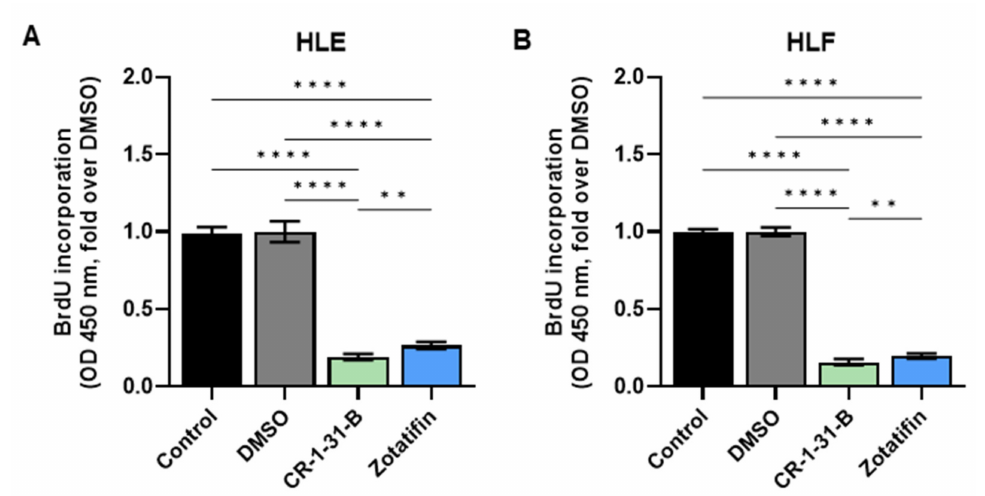
Figure 7. Effects of the eIF4A inhibitors, CR-1-31-B and Zotatifin, on the proliferation of hepatocellular carcinoma cell line monolayer cultures indicated by BrdU incorporation. BrdU incorporation assay was conducted on ( A ) HLE and ( B ) HLF cells treated for 48 h with 10 nM CR-1-31-B and 20 nM Zotatifin. Untreated cells and cells treated with DMSO served as controls. The fold-changes over DMSO of optical densities (OD) at 450 nm are presented. All results are expressed as mean ± SD of three independent experiments in triplicate. For statistical analysis, Tukey’s multiple comparisons test was performed (** p < 0.1; **** p < 0.001).